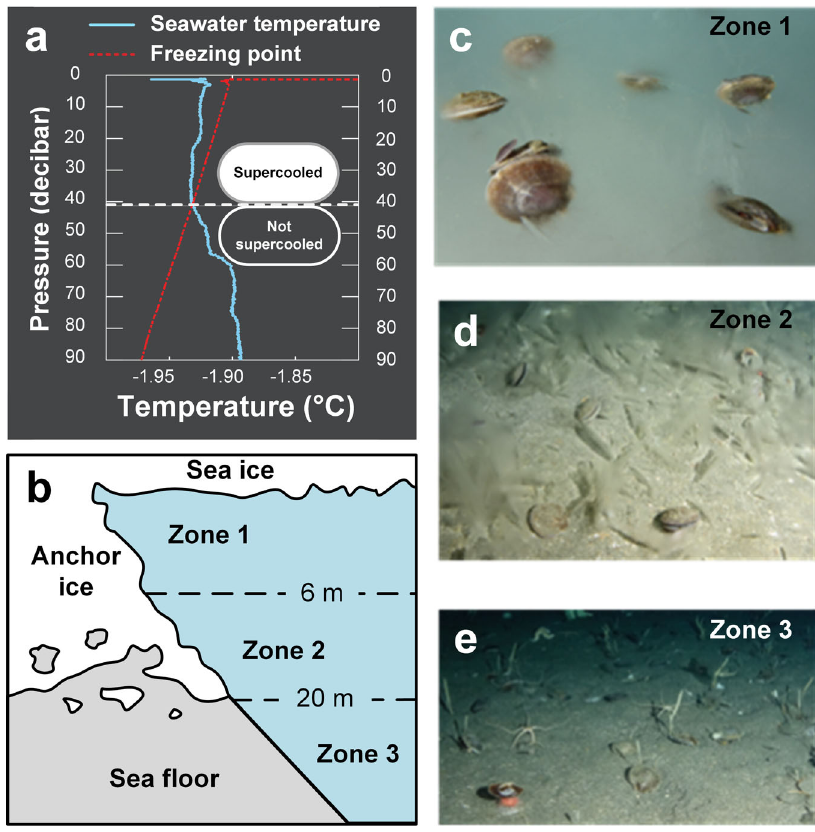
Fig. 1 Antarctic scallops inhabit anchor-ice zones in Antarctica yet appear to remain ice-free. a Typical vertical pro fi le of seawater conditions in austral spring in McMurdo Sound, Antarctica (14th Nov, 2012) showing seawater supercooling. Seawater supercooling drives anchor-ice growth, the prevalence, and thickness of which typically increases towards shallower depths. b Schematic representation of the anchor-ice zones in Explorer ’ s Cove, McMurdo Sound, Antarctica, informally de fi ned herein using the de fi nitions established by Dayton et al. 26 . c – e In Explorer ’ s Cove, Antarctic scallops occur in all zones, including the heavily anchor ice impacted shallowest areas (Zone 1, c ) where they are found atop the growing anchor-ice blanket. Despite the abundant ice accretion on rocks and sediment in Zones 1 and 2, cryofouling of the exterior of the scallops ’ mineral shells was never